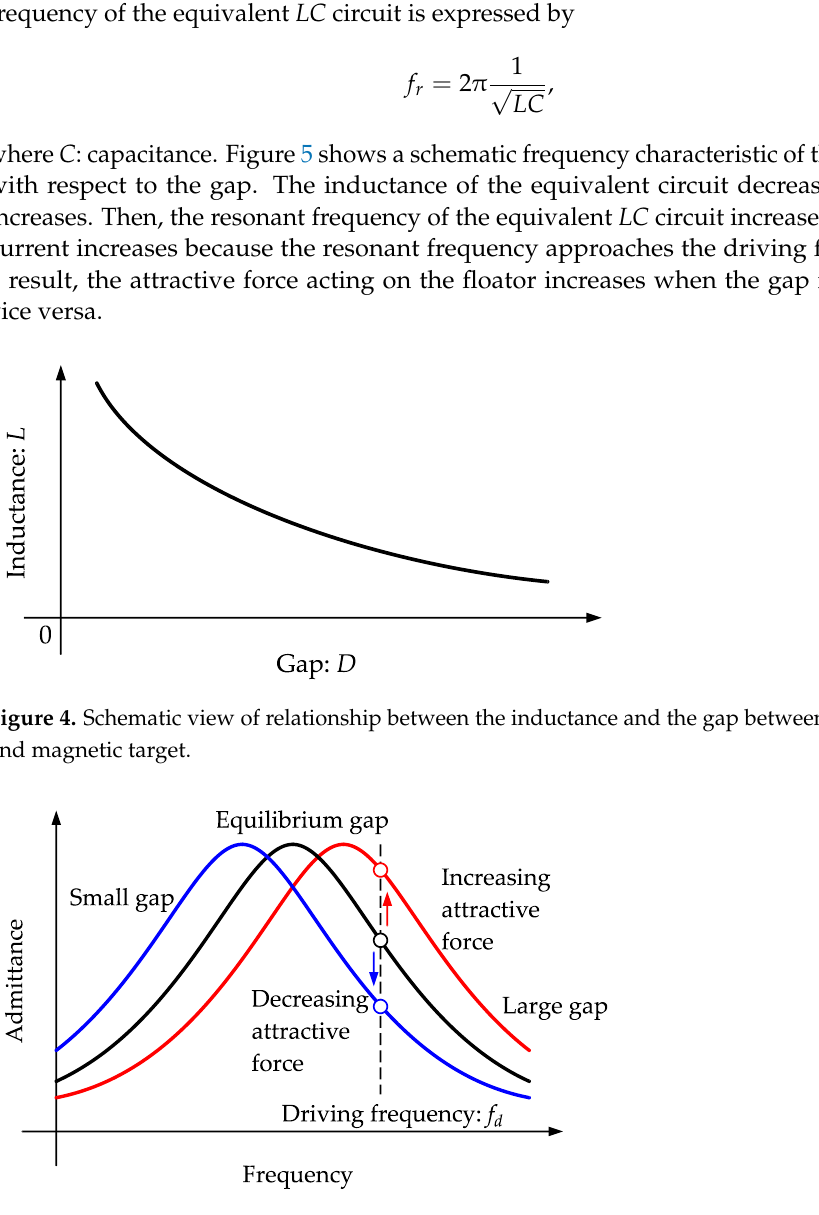
Figure 5. Schematic frequency characteristic of the admittance in the equivalent LC resonant circuit and the series connected capacitor with respect to the gap. Black line represents a characteristic of admittance at the equilibrium gap. Blue line represents a characteristic at a small gap. Red line represents a characteristic at a large gap. The dashed line represents a driving frequency of the AC signal generator. White circles represent the admittance at the driving